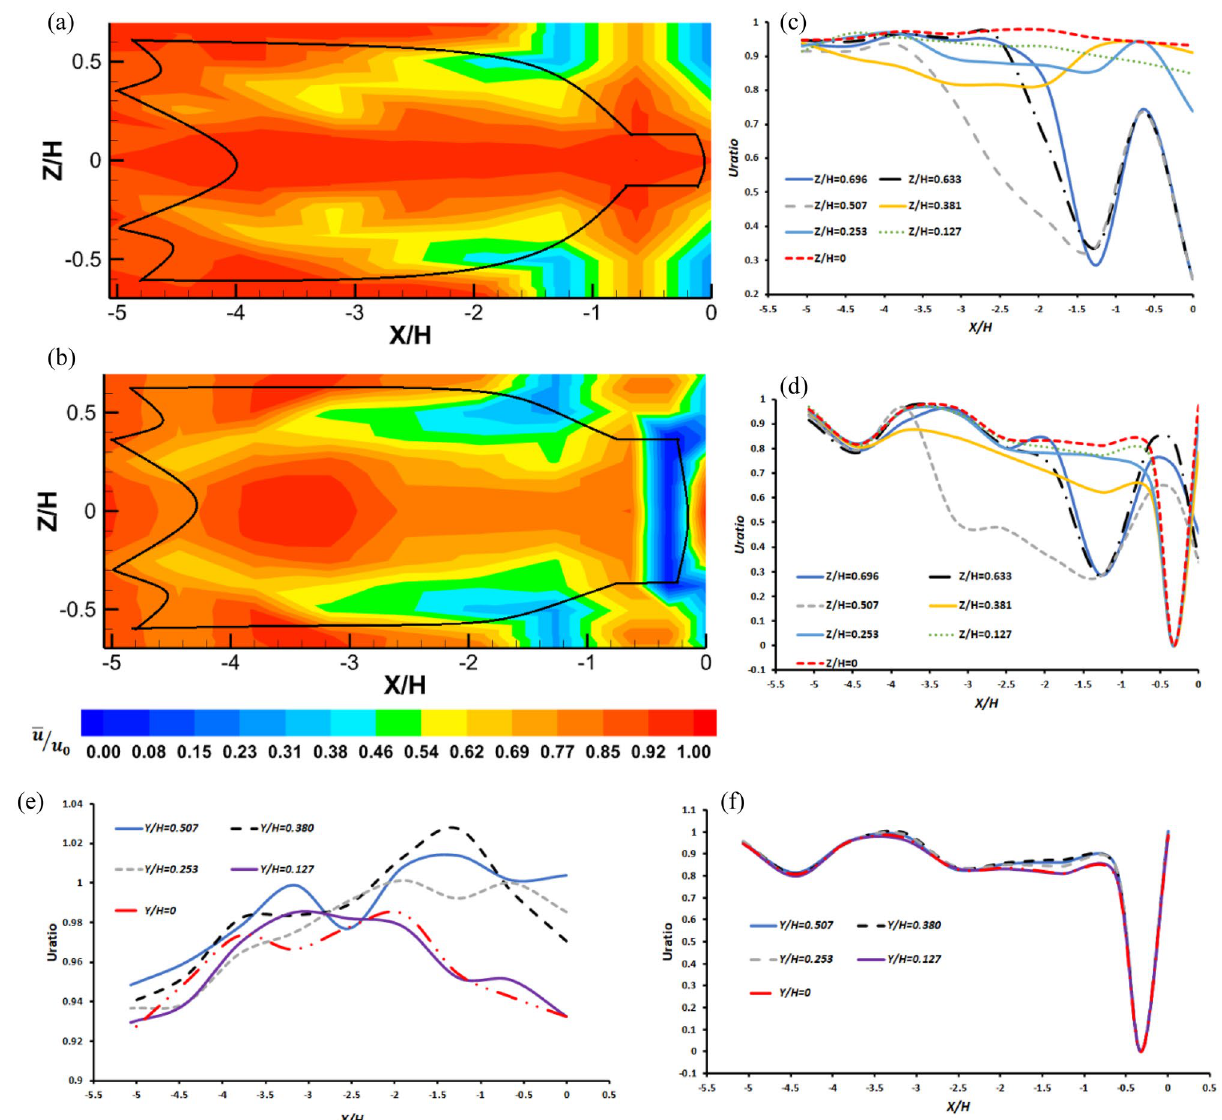
Figure 5. Mean streamwise flow velocity ( u / u 0 ) develops inside and around midwater trawl net ( a ) Trawl without catch and ( b ) Trawl with catch, and the velocity curves along the X/H direction as function of Z /H at Y /H = 0 ( c and d ) and Y/H at Z/H = 0 ( e and f ) for trawls without catch and with catch,